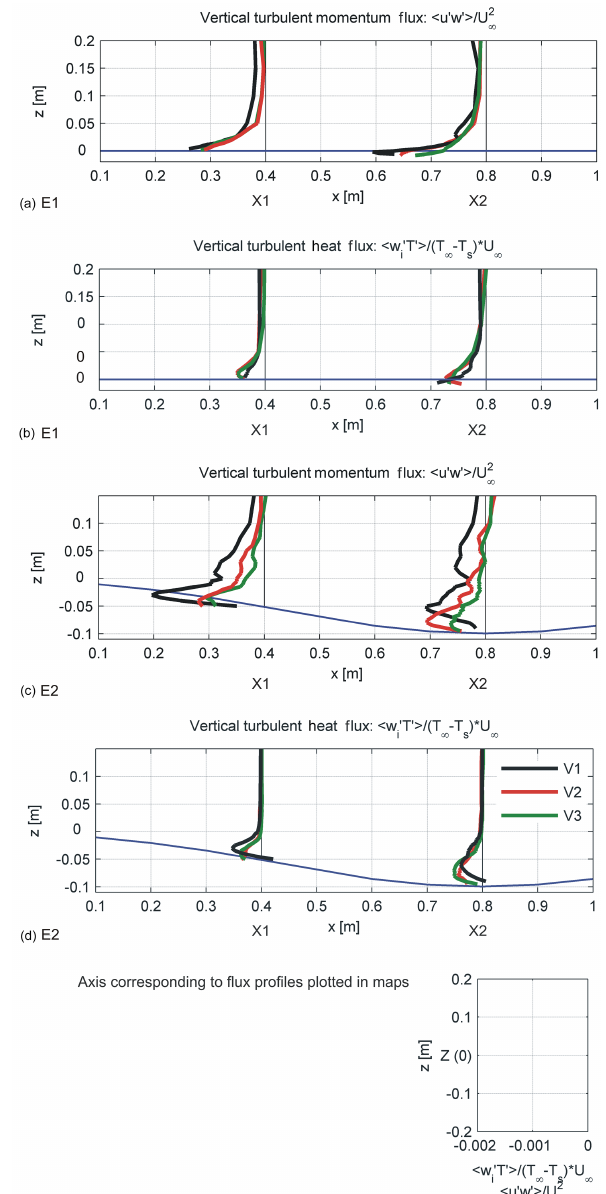
Figure 3. Vertical profiles of the turbulent fluxes: momentum flux u (cid:48) w (cid:48) and turbulent vertical heat flux w (cid:48) T (cid:48) normalized by the tem- perature difference and free-stream wind velocity, plotted at the cor- responding measurement location along the snow patch for the flat and concave setups. The axis corresponding to the flux profiles is plotted outside of the individual